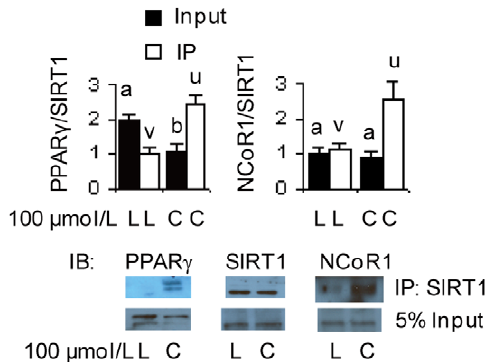
Figure 7. Treatment with t 10 c 12 CLA increases the interaction of SIRT1 with PPAR c or NCoR1. Differentiated 3T3-L1 adipocytes were incubated with 100 m mol/L LA (L) or t 10 c 12 CLA (C) for 12 h, and a portion of the nuclear extracts were immunoprecipitated with antibody to SIRT1 (IP: SIRT1). Representative immunoblots (IB) indicate the proteins detected from the nuclear extracts (5% input) or when the immunoprecipitated proteins were probed with antibodies to SIRT1, PPAR c , or NCoR1. Each bar represents the mean + SEM (n=3) of three independent experiments. Means within each data type not sharing a common letter differ, P ƒ 0.05. palmitoyltransferase-mediated transport of fatty acids into mito- chondria for b -oxidation [18,19,50]. Fatty acid synthesis was also